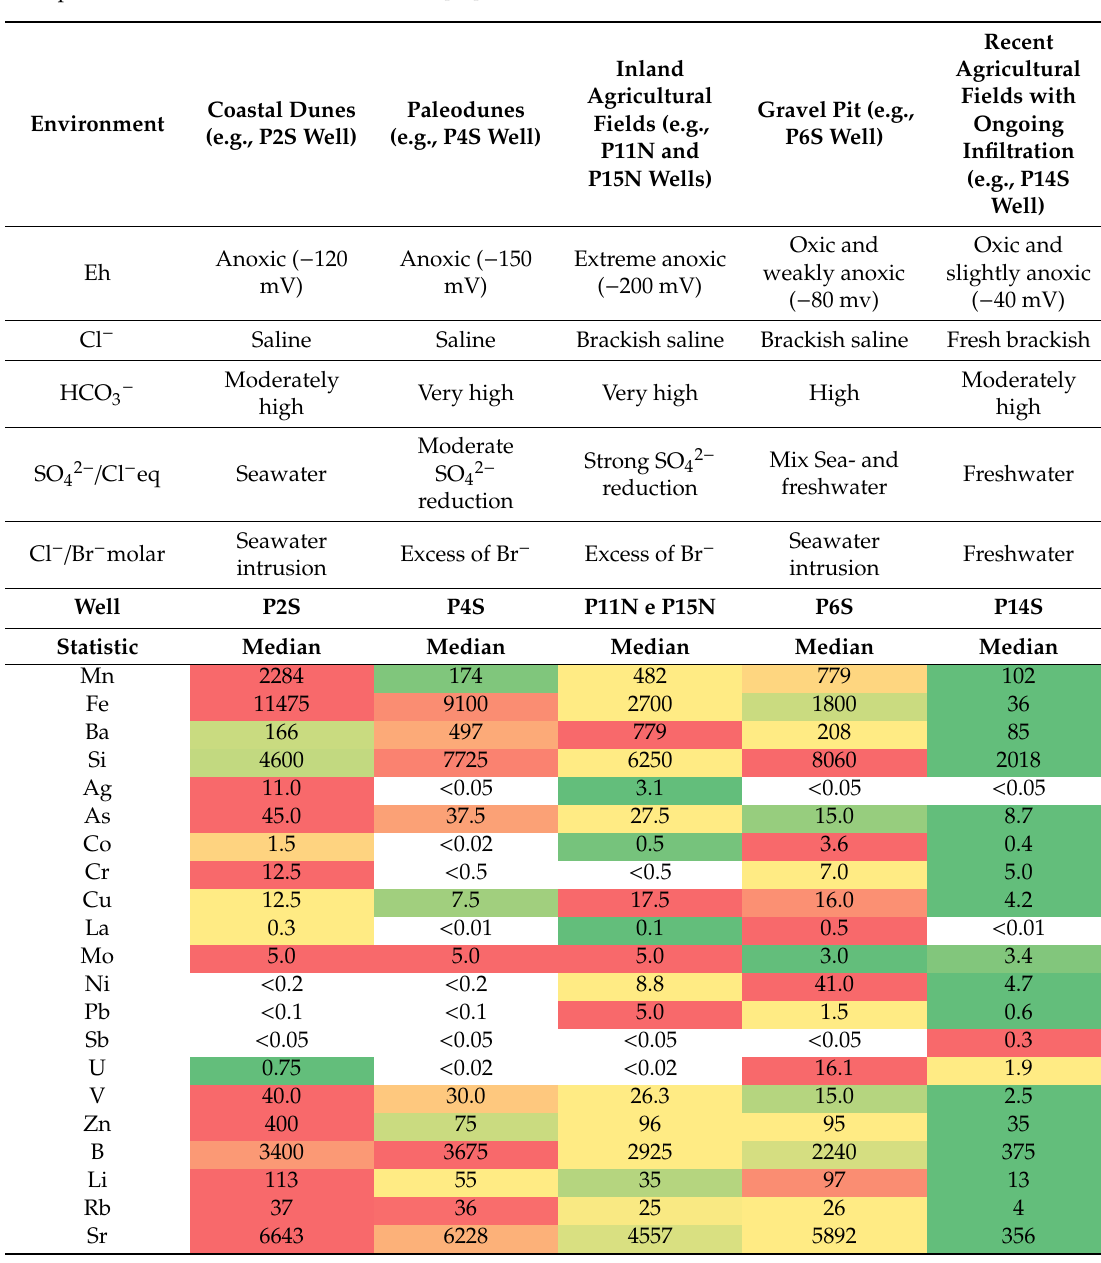
Table 2. Summary of geochemical processes occurring in 5 selected environments in the study area. Color scale from red to green indicates from the highest to the lowest concentrations, respectively. TEs concentrations are in µ g / L. Eh, Cl − , HCO 3 − are categorized using thresholds proposed by Stuyfzand 1989 [21]. SO 42 − / Cl − equivalent ratio processes refer to Colombani et al. [12], Cl − / Br − molar ratio processes refer to Alcal à and Custodio